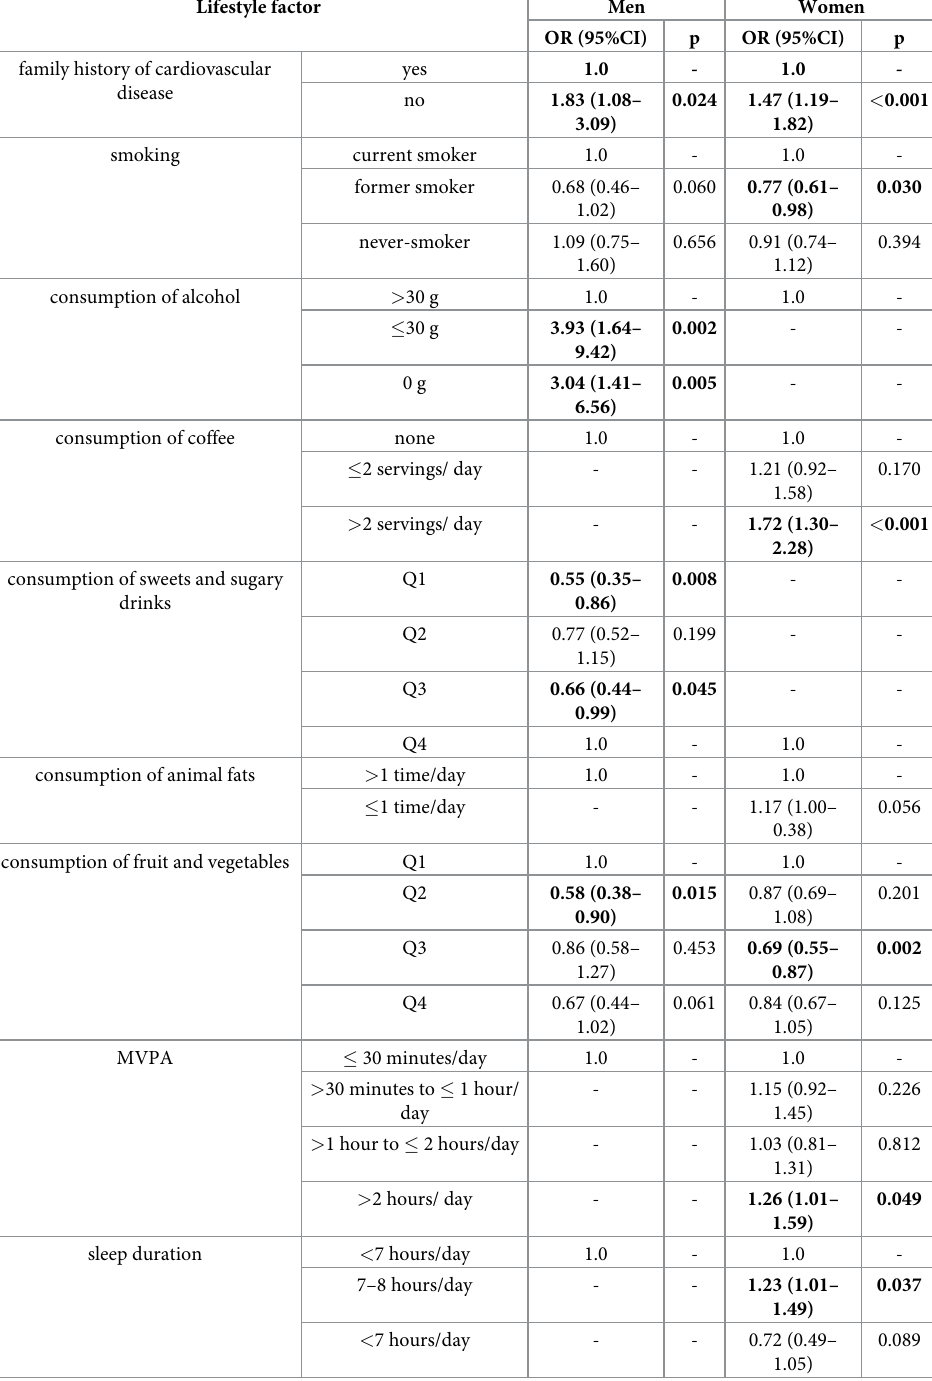
Table 5. Factors associated with metabolic health. Multivariate analyses with backward stepwise selection results for � 1 components of MetS in men and